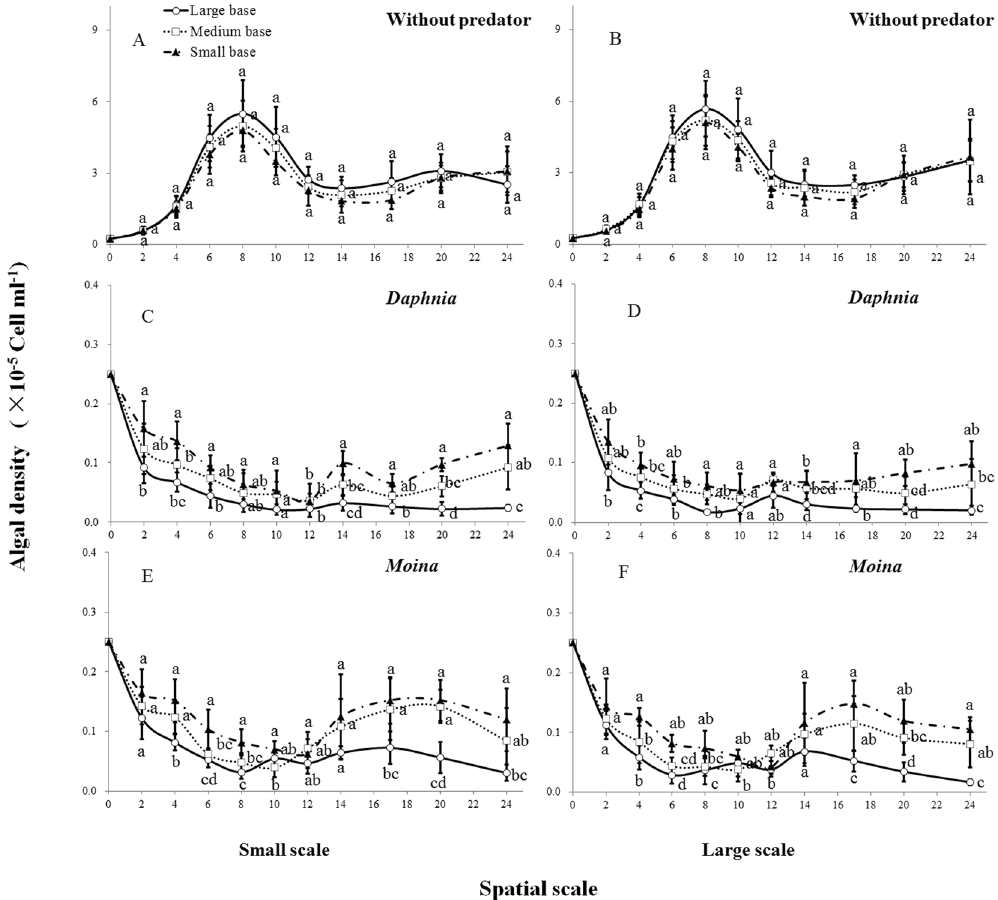
Figure 6. Cell density (means ± 1 s.d., n = 6) of Chlorella pyrenoidosa in the absence ( A,B ) and presence of grazers [ Daphnia magna ( C , D ) or Moina micrura ( E,F )] under three levels of habitat orientation and two levels of spatial scale. Different letters indicate significant differences among treatments on a specific day. Multiple comparisons of means were performed using Tukey’s test at the 0.05 significance level. Figure 5 was created using Microsoft Excel